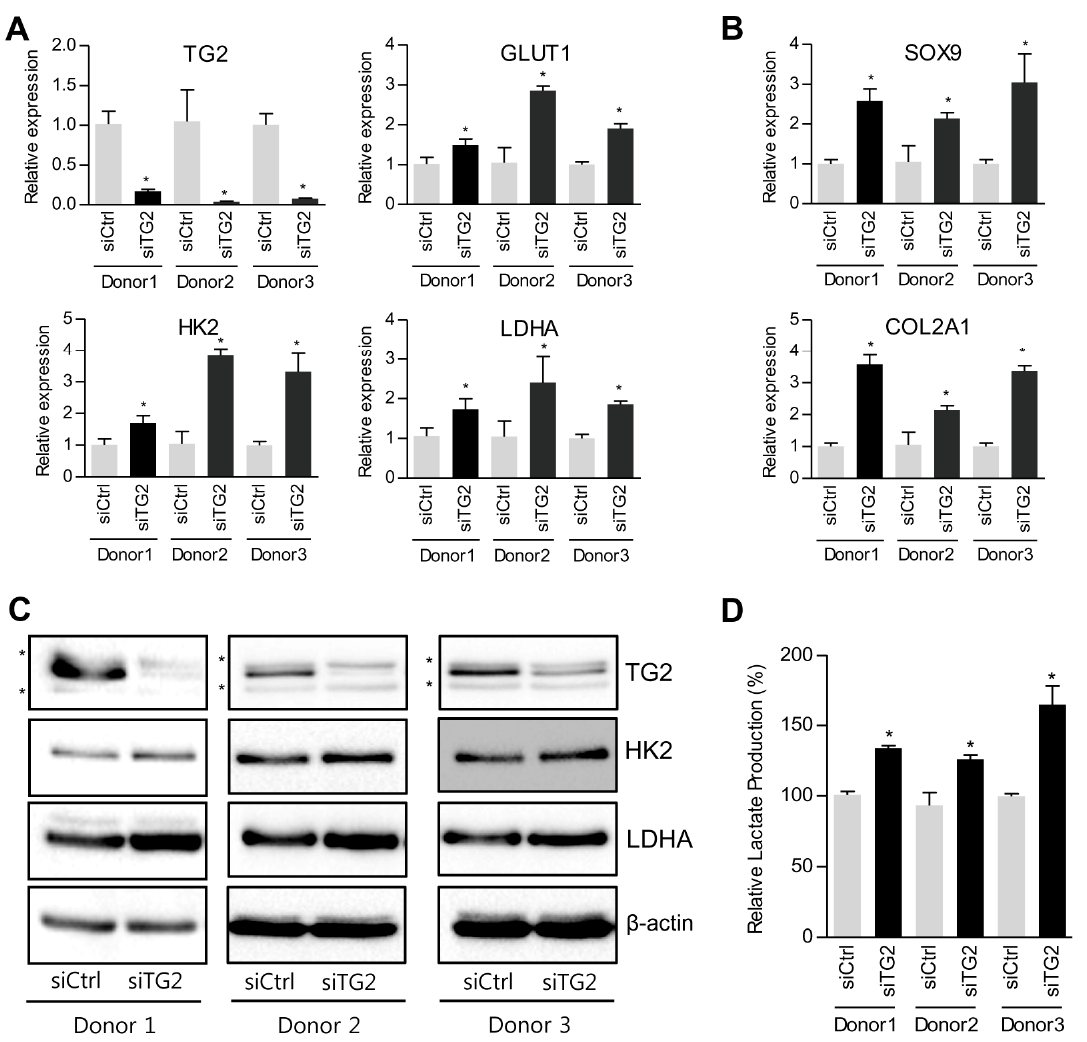
Figure 4. Metabolic reprogramming by TG2 knockdown in dedifferentiated chondrocytes. Passage 5 human articular chondrocytes were transfected with TG2-specific siRNA or non-silencing control siRNA. ( A ) TG2, GLUT1, HK2 and LDHA mRNA levels were quantified by real-time qPCR. ( B ) The mRNA expression levels of chondrogenic markers (SOX9 and COL2A1) were measured by real-time qPCR. ( C ) The protein expression levels TG2, HK2 and LDHA were quantified by western blot analysis. Asterisks denote other TGs. β -actin was used as a loading control. ( D ) Extracellular lactate levels secreted by cells transfected with control siRNA or TG2 siRNA. Lactate concentration of non-silencing control siRNA transfected cell samples was assigned as 100%. Data represent mean values ± SD from at least three independent experiments. * p < 0.05. n = 3.